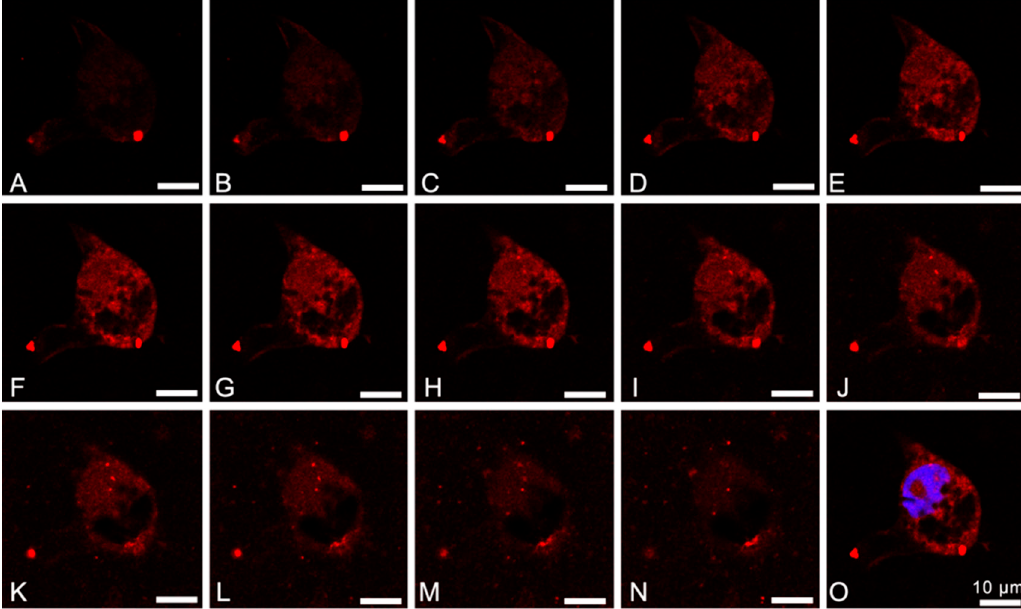
Figure 4. ( A – N ): Serial sections with 0.30 µ m / section of a LoVo cell co-incubated with FA-PEG@MNP conjugated with rhodamine, and with NaBu. ( O ): Panel corresponding to the central serial section H with the visualization of the nucleus (stained in blue with DAPI). Scale bar: 10 µ m.